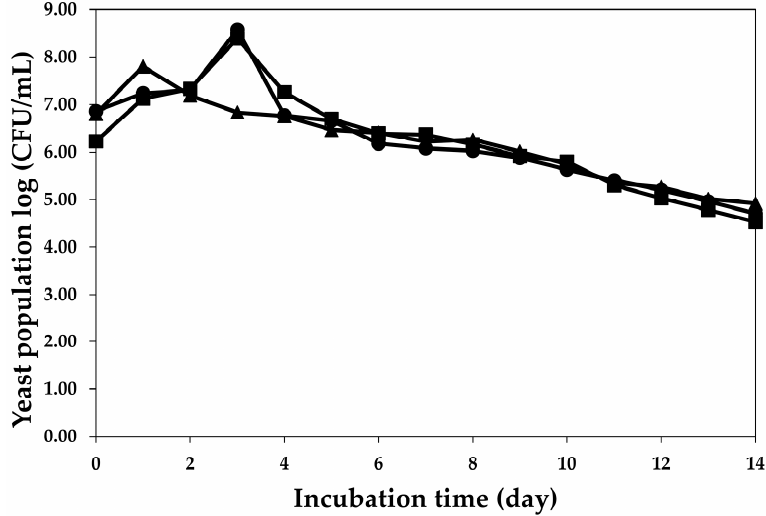
Figure 3. Change in yeast population during plum wine fermentation using S. cerevisiae var. burgundy ( ), H. thailandica Zal1 ( ), and EC1118 ( ).